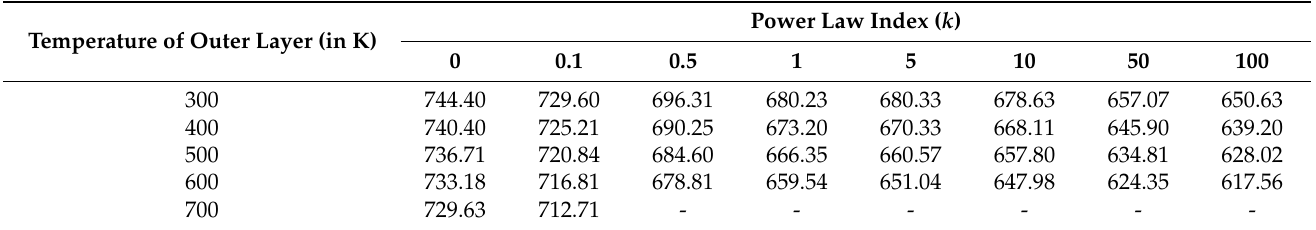
Table 12. Critical buckling temperature (in K) of a Ti-6Al-4V/aluminum oxide FGM shell under linear temperature rise for different material composition in re-entry vehicle nose